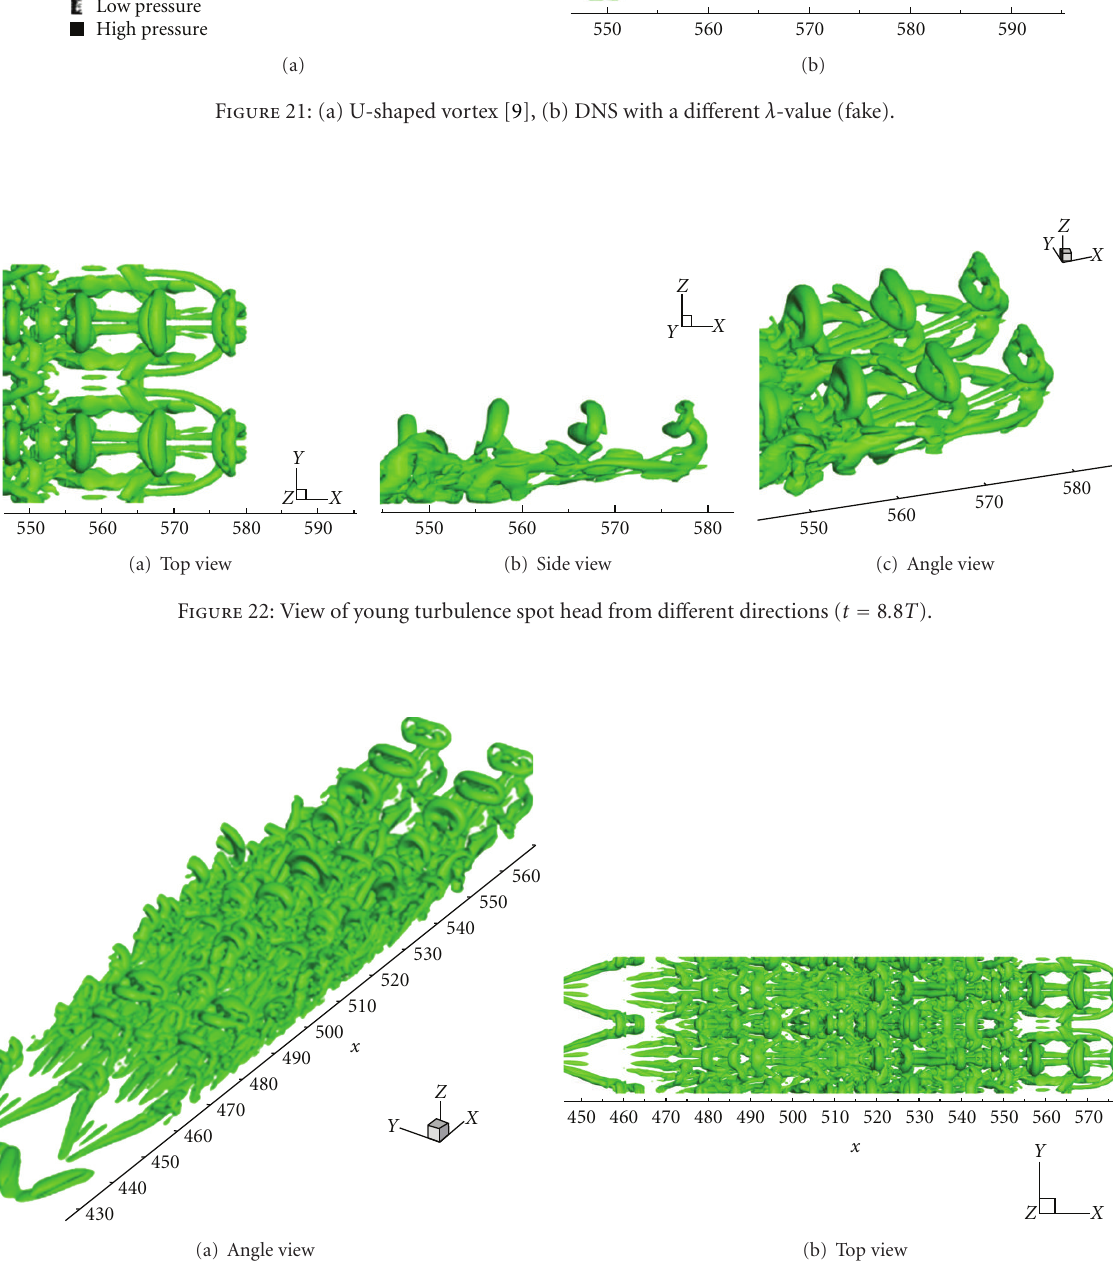
Figure 23: 3D angle view and 2D top view of the young turbulence spot ( t = 8 . 8 T